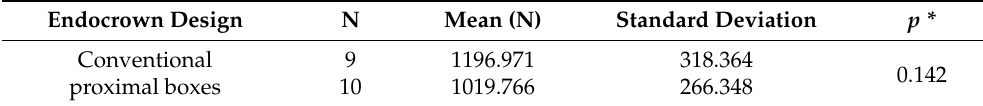
Figure 4. Analysis of endocrown designs’ fracture resistance of conv entional and proximal boxes. Results of the Mann-Whitney U-test of fracture resistance test in Newtons (N) are detailed in Table 1. The test showed an insignificant difference between the two endo- crown preparation design groups ( p = 0.142). Endocrown Table 1. Mann-Whitney U-test results of fracture resistance test in Newtons (N).